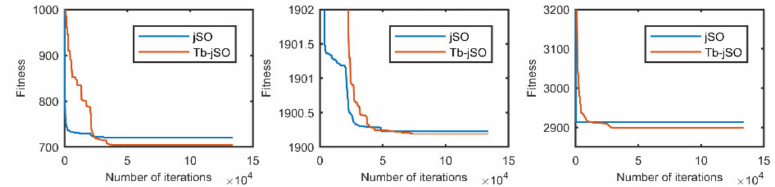
Figure 12. The selected average convergence of jSO and Tb-jSO is compared on CEC2020 in 20 D . From left to right f3, f4 and